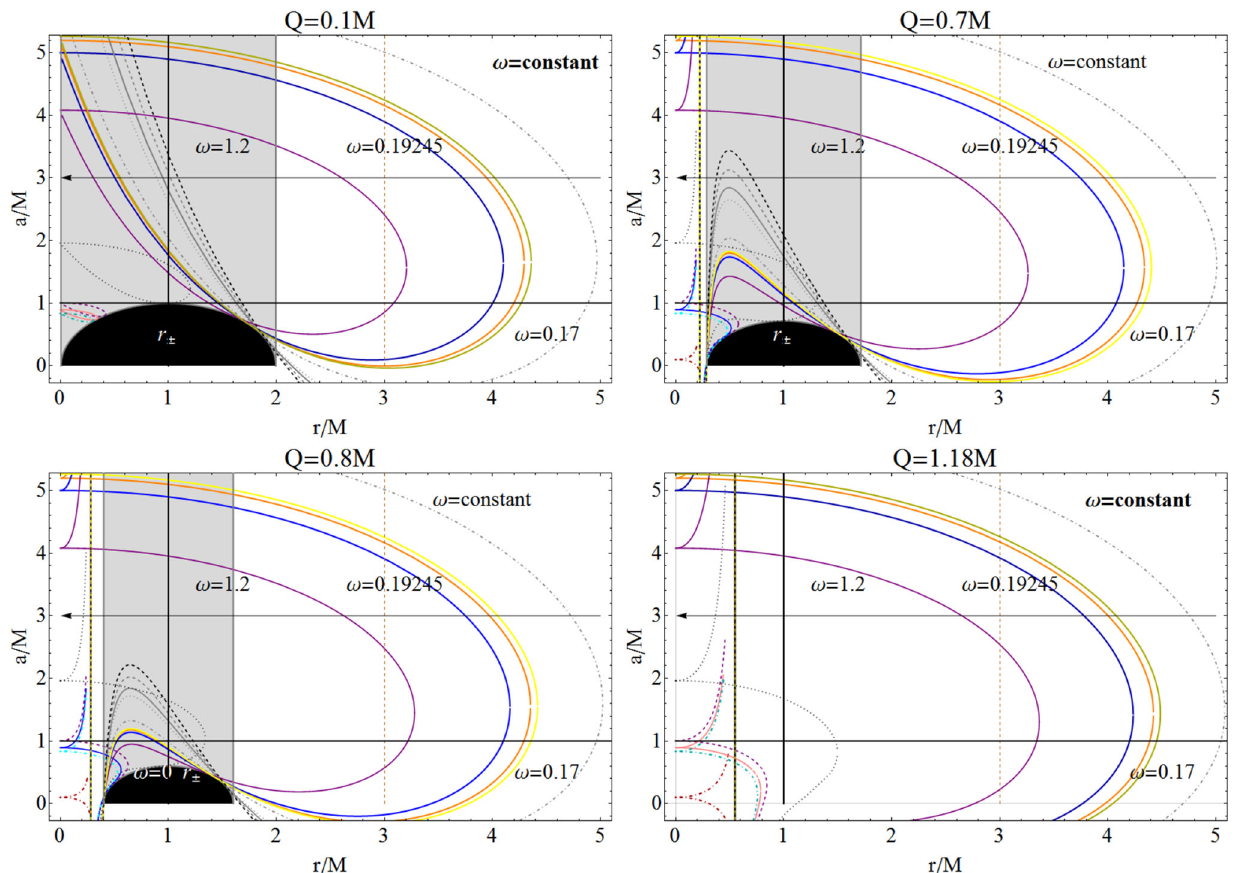
Fig. 25 Equatorial plane of Kerr–Newman spacetimes: the surfaces ω ± = constant as functions of the radius r / M and the spin a / M – Eq. (34), for different charges Q . This is a generalization to the case